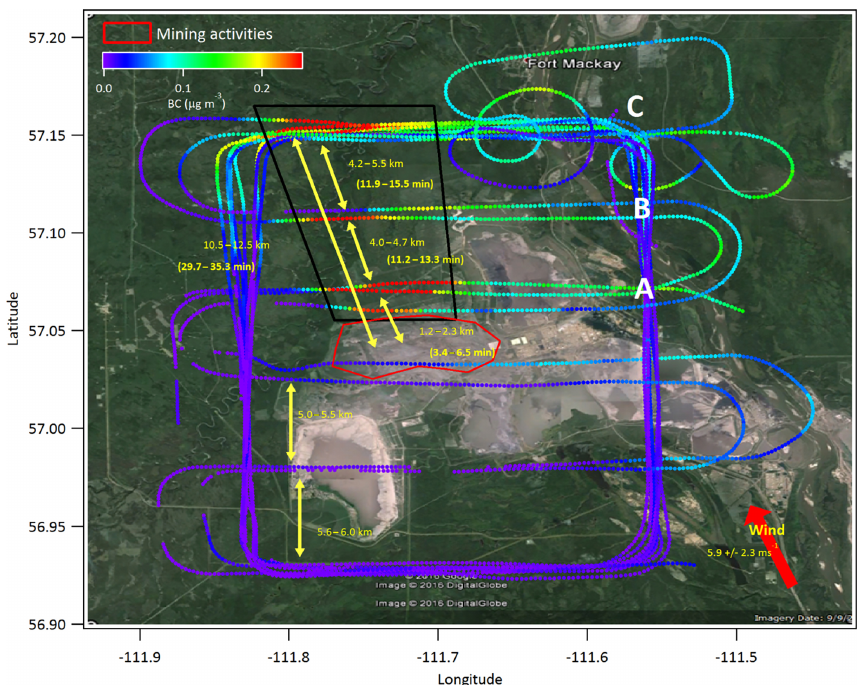
Figure 3. Concentration of BC during emission Flight 18 (Syncrude – ML), showing horizontal transects A–C within the box and closest to the mining emission source (red box). Time in brackets represents the approximate time between horizontal transects or from the approximate centre of the mine to the closest transect. The time is calculated based upon the average wind speed during this portion of the flight. The range in values is based upon differences in time calculated from the northernmost and southernmost legs of transects